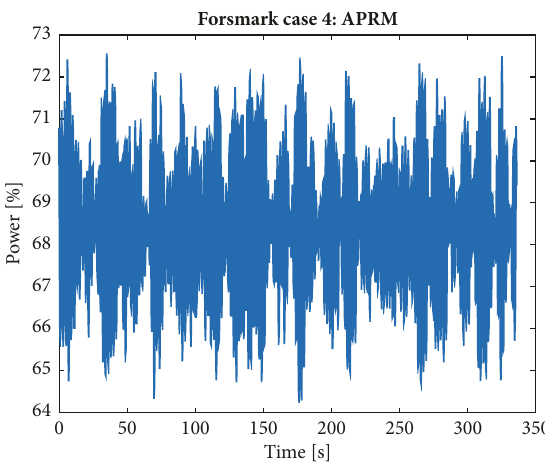
Figure 17: Forsmark Case 4 APRM